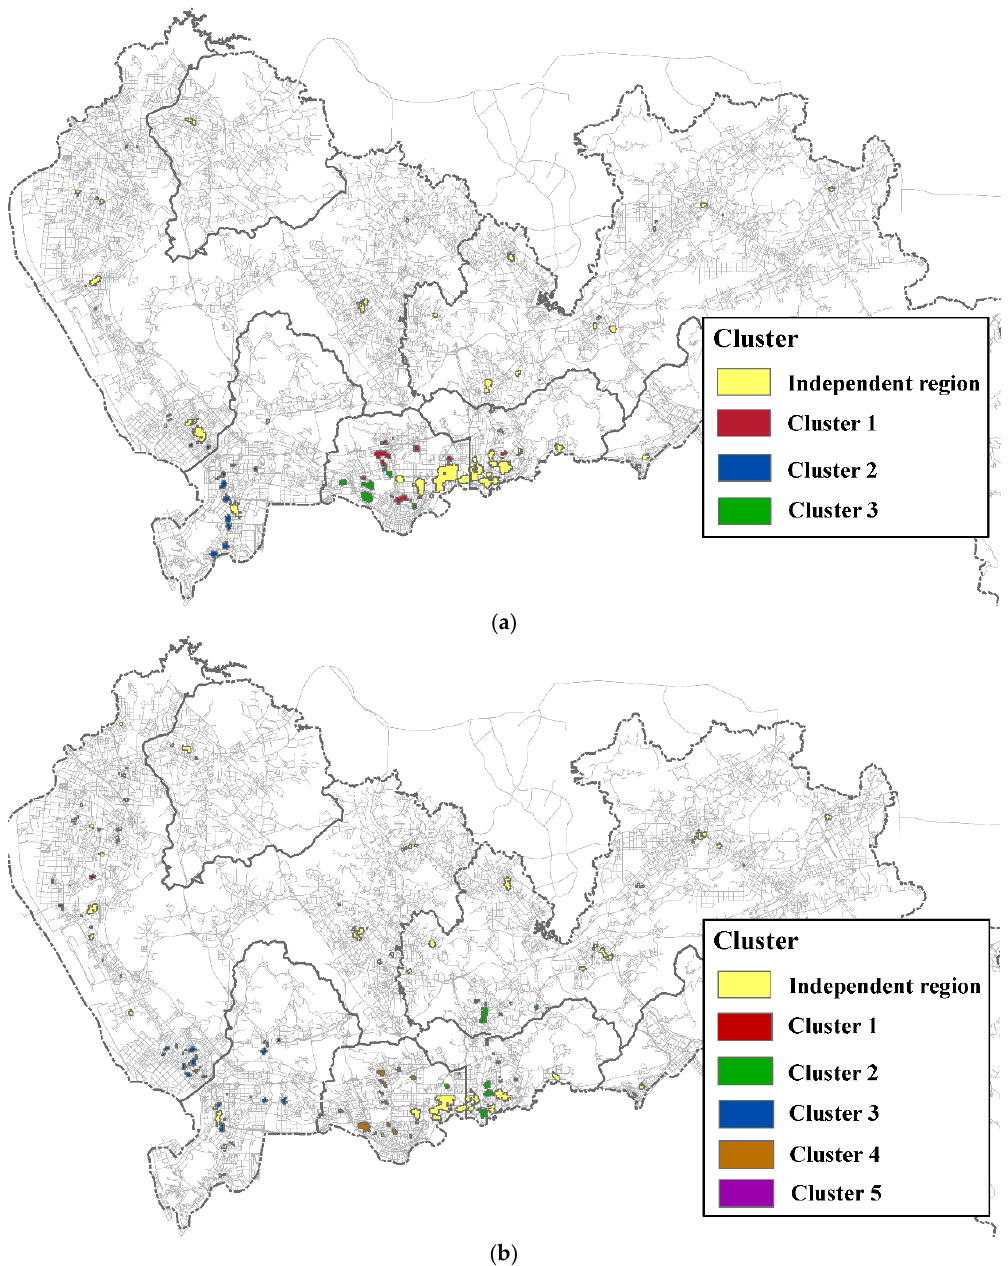
Figure 9. Results of clustering prevalent regions using a combination of location-based and environmental variables, for the: ( a ) size-2 pattern {bank, retail store}; and ( b ) size-3 pattern {bank, retail store, hotel}.